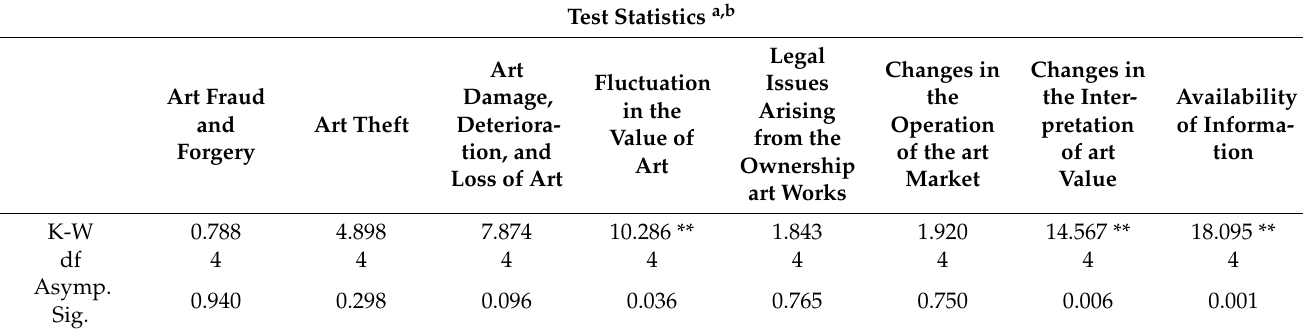
Table 15. Effects of occupation/field of study on art risk perception. Test Statistics